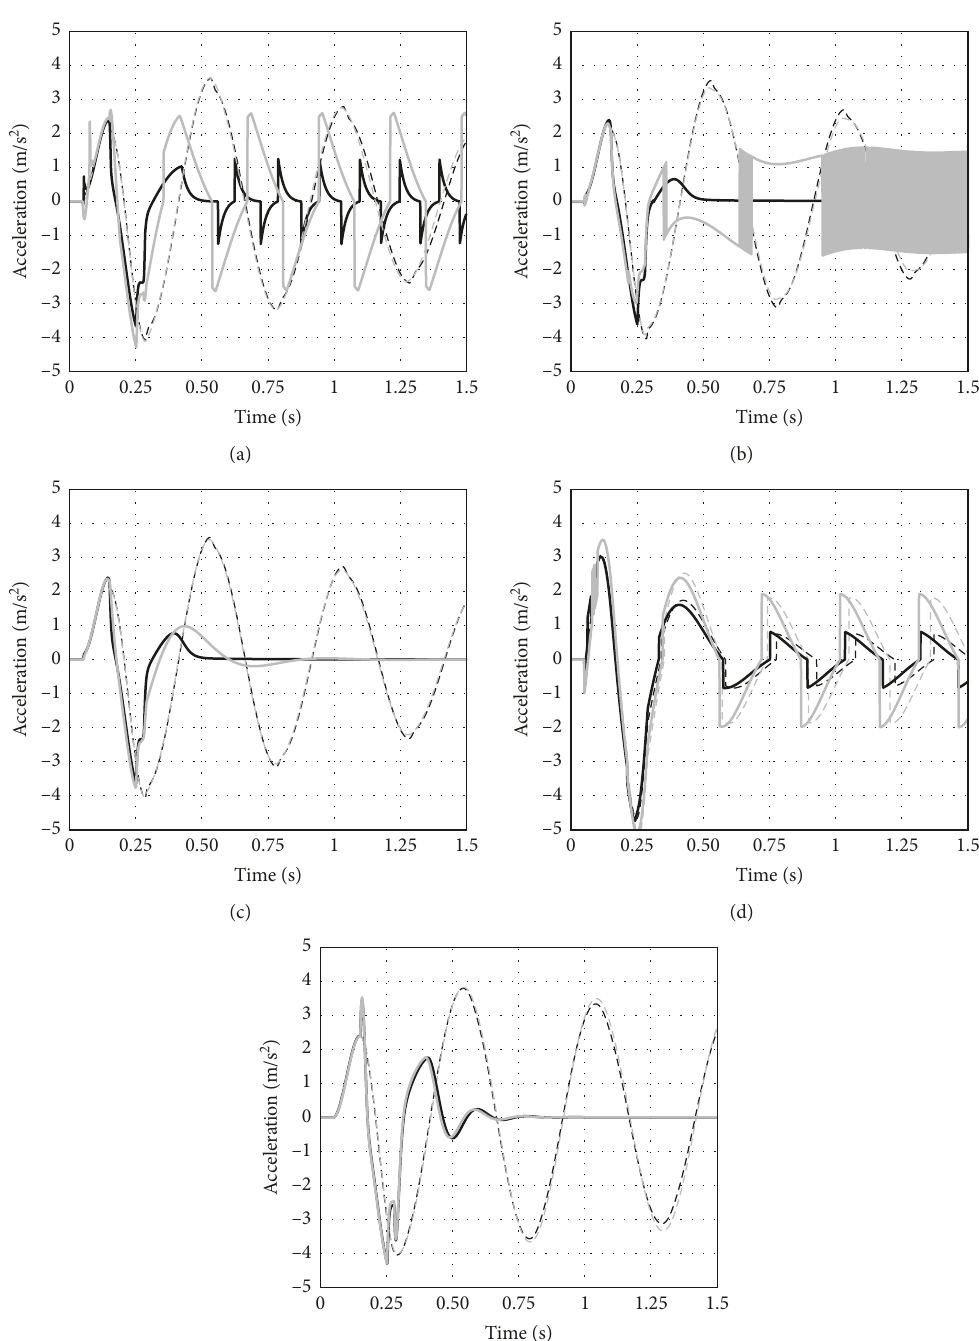
Figure 19: Time response of the controlled (solid line) and passive (dotted line) sprung mass acceleration for the (a) hysteretic biviscous model, (b) hysteretic regularised Bingham model, (c) Shuqi-Guo model, (d) polynomial model, and (e) Spencer model, after LMH fitting (black) and MH fitting